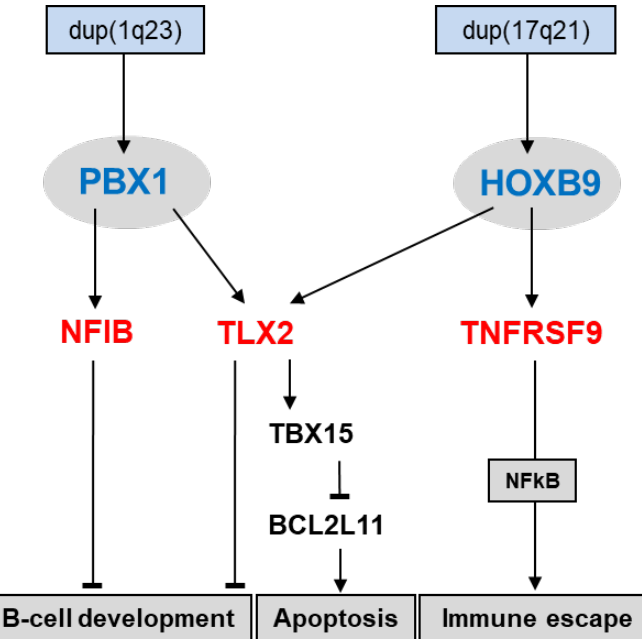
Figure 4. This diagram shows the activation and function of aberrantly expressed TALE homeobox gene PBX1 and HOXL homeobox gene HOXB9 in HL. Both genes are targeted by genomic copy number gains. PBX1 activates NFIB and TLX2, while HOXB9 activates TLX2 and TNFRSF9. NFIB and TLX2 mediate the inhibition of B-cell development, and TLX2 inhibits apoptosis via TBX15 and BCL2L11. TNFRSF9 supports aberrant immune escape via NFkB-signaling.